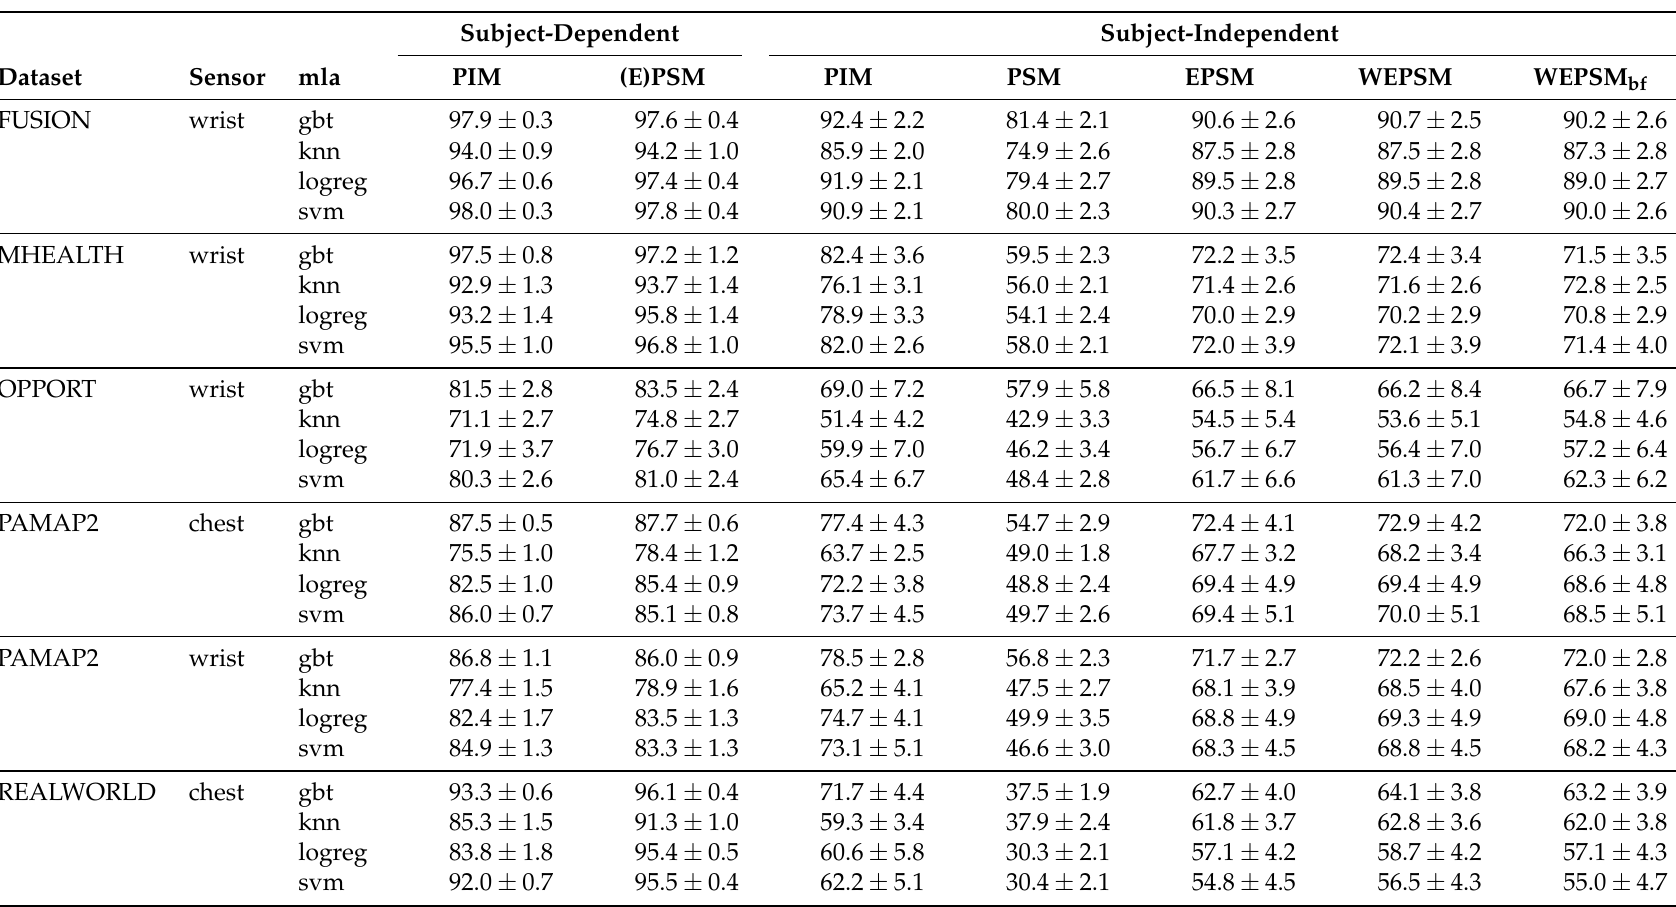
Table 2. Subject-dependent and subject-independent κ (%) ± standard error when learning algorithms (mla) are combined with a person-independent model (PIM), a person-specific model (PSM), an unweighted ensemble of PSMs (EPSM), a κ -weighted EPSM (WEPSM), or a baseline-feature-weighted EPSM (WEPSM bf